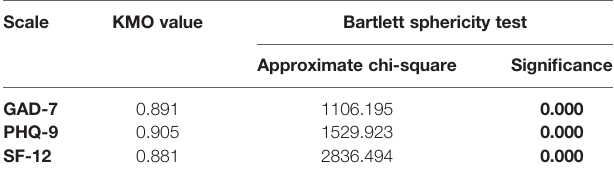
Bold indicates p <